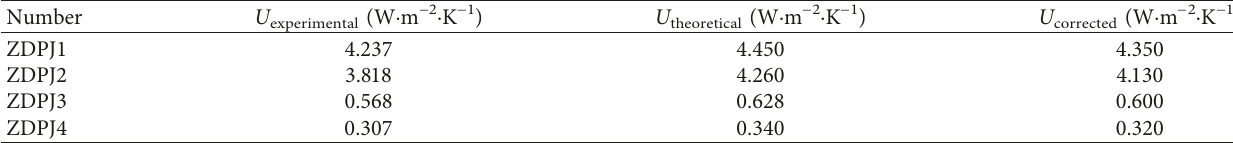
Table 2: Comparison between measured values, theoretical values, and corrected computation values of wall heat transfer coefficient.